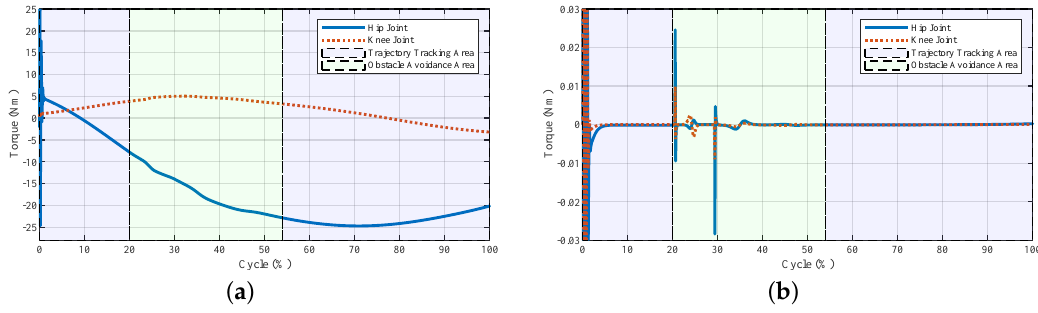
Figure 5. Joint powers of the system during stepping over the obstacle. ( a ) Torques of the exoskeleton and ( b ) torques of the